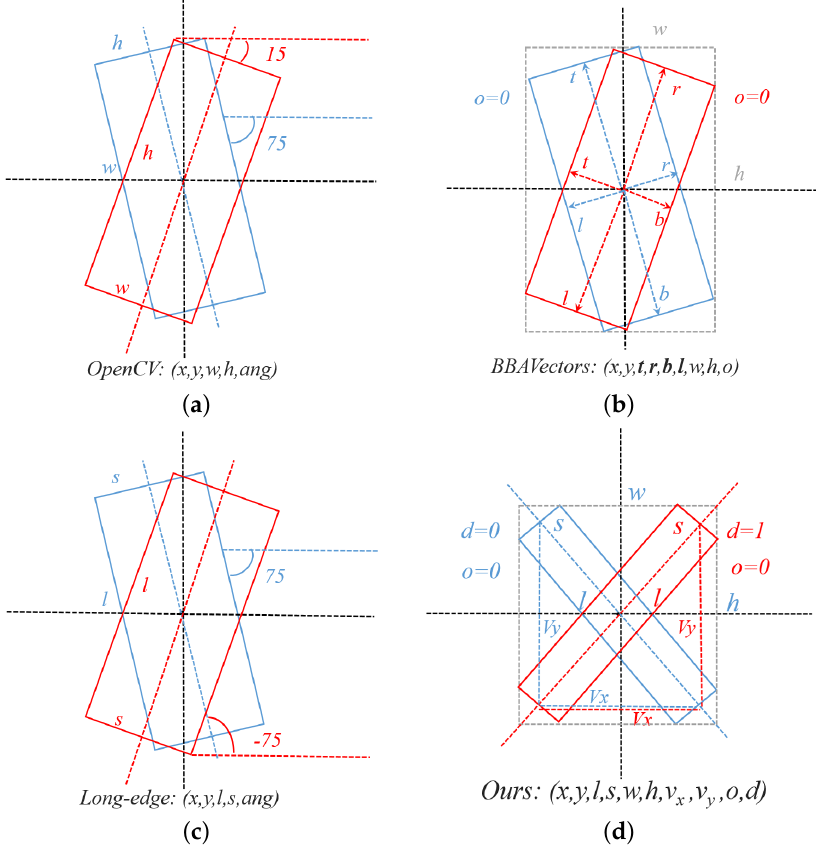
Figure 2. Schematic diagram of the different RBB encodings: ( a ) Opencv encoding; ( b ) long-edge encoding; ( c ) BBAVectors encoding; ( d ) our proposed encoding.